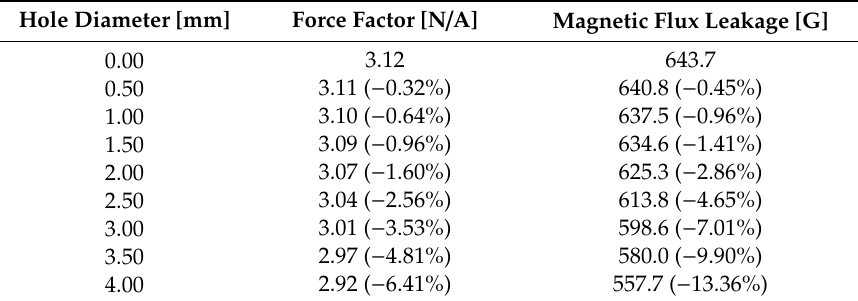
Table 4. Analysis results with different hole diameters.